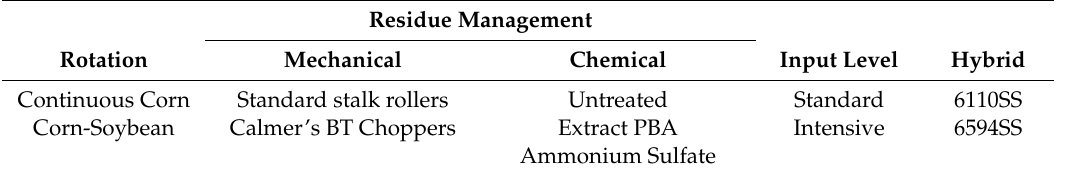
Table 1. Treatments used in the evaluation of corn residue management, input intensity, and germplasm influences on the continuous corn yield penalty (CCYP) at Champaign, IL during 2017 and 2018. Two rotations each received two mechanical and three chemical residue management treatments in combination with two input levels described in the Materials and Methods section and two